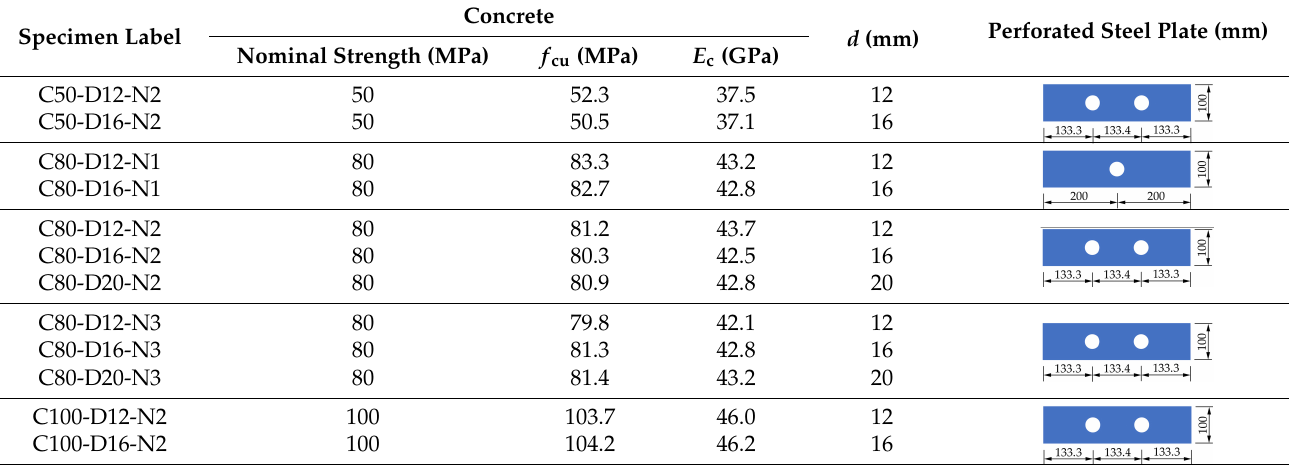
Figure 2. Fabrication of test specimens: ( a ) PBL processing; ( b ) rebar tying; ( c ) completed casting. Table 1. Test specimen